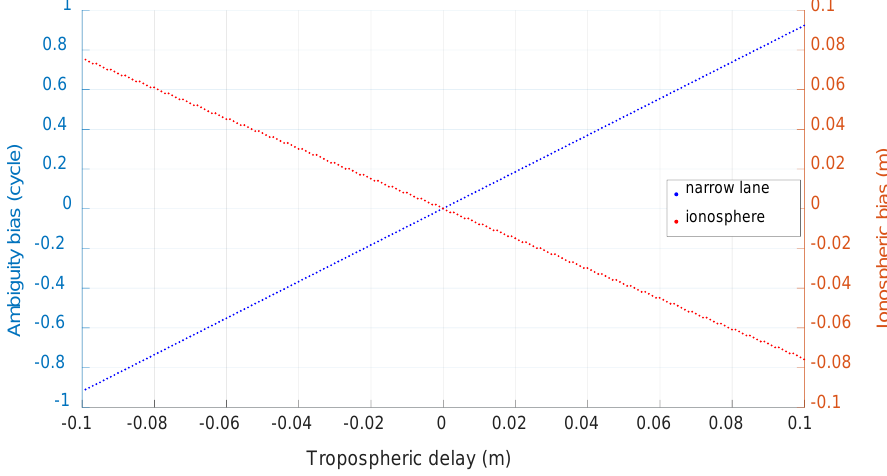
Figure 14. The caused bias of neglected tropospheric error (Galileo).